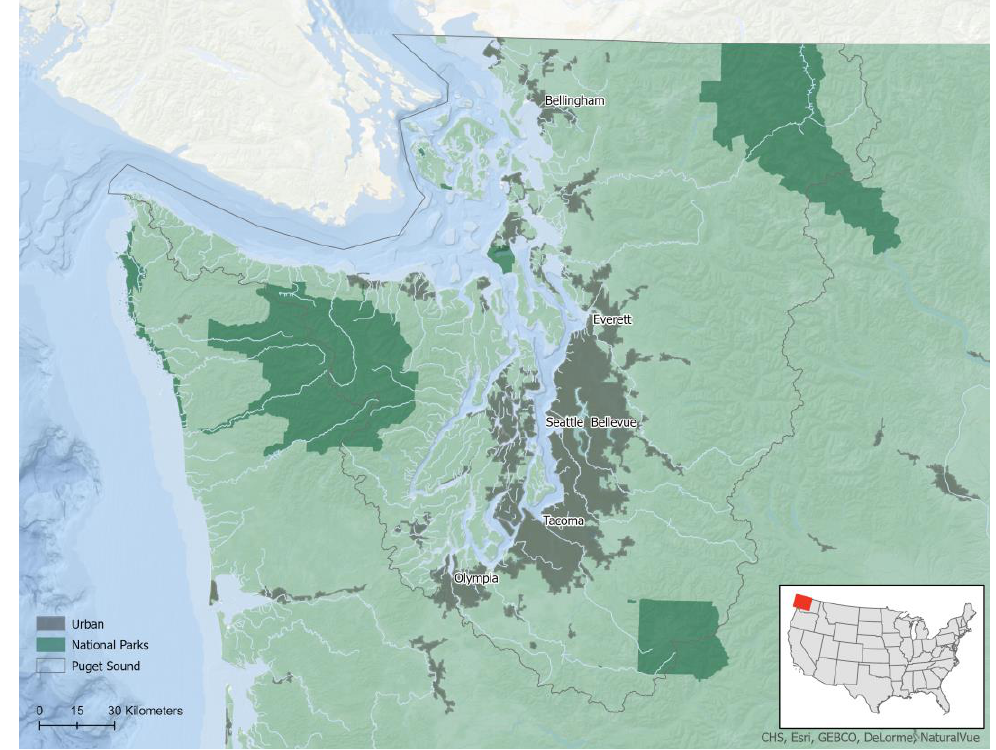
Figure 1. Map of Puget Sound, USA study region. Urbanized areas are shown in gray, National Parks are shown in dark green.